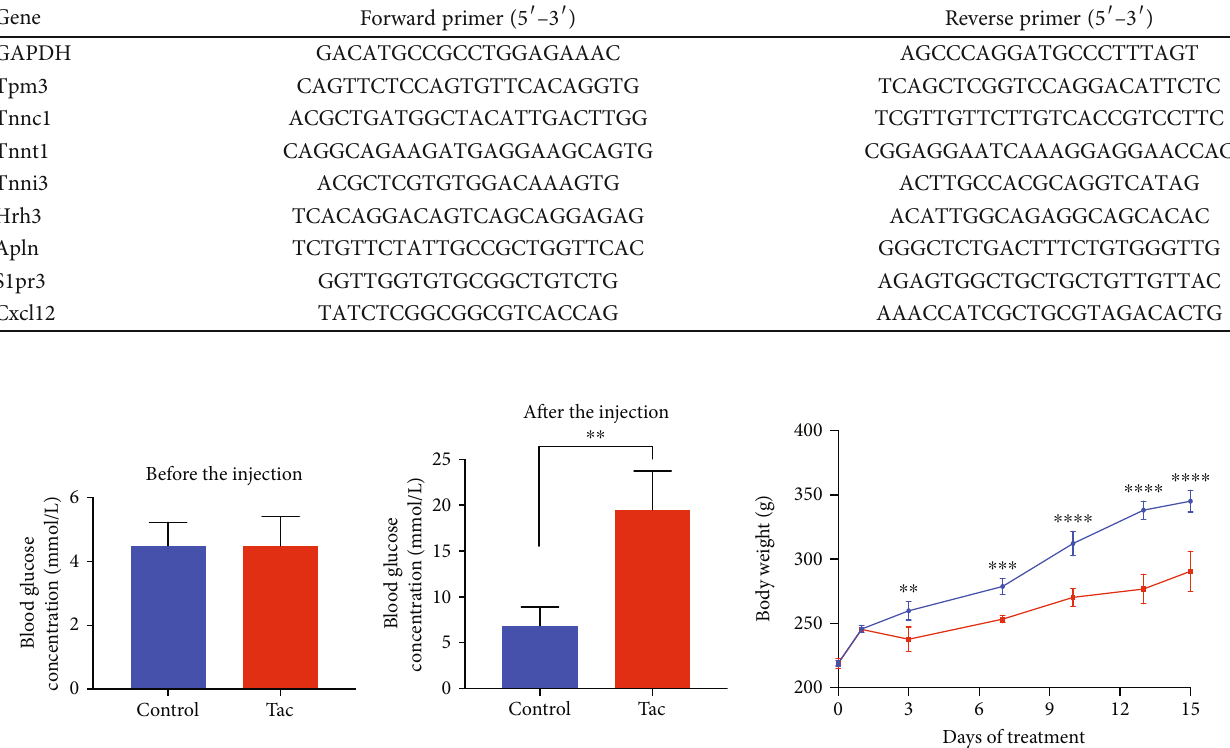
Table 1: Sequences of the primers used for quantitative real-time PCR.